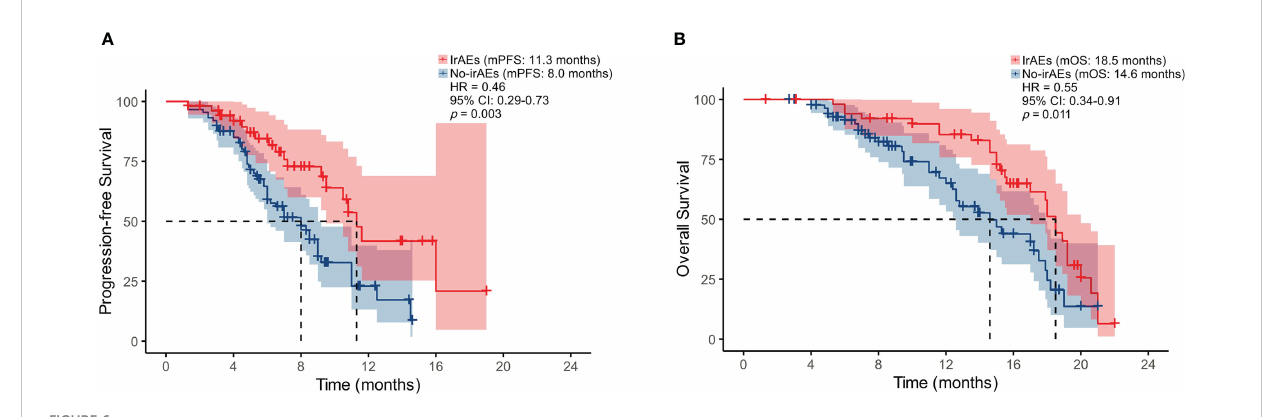
FIGURE 6 Kaplan-Meier analysis of PFS (A) and OS (B) based on the onset of irAEs.